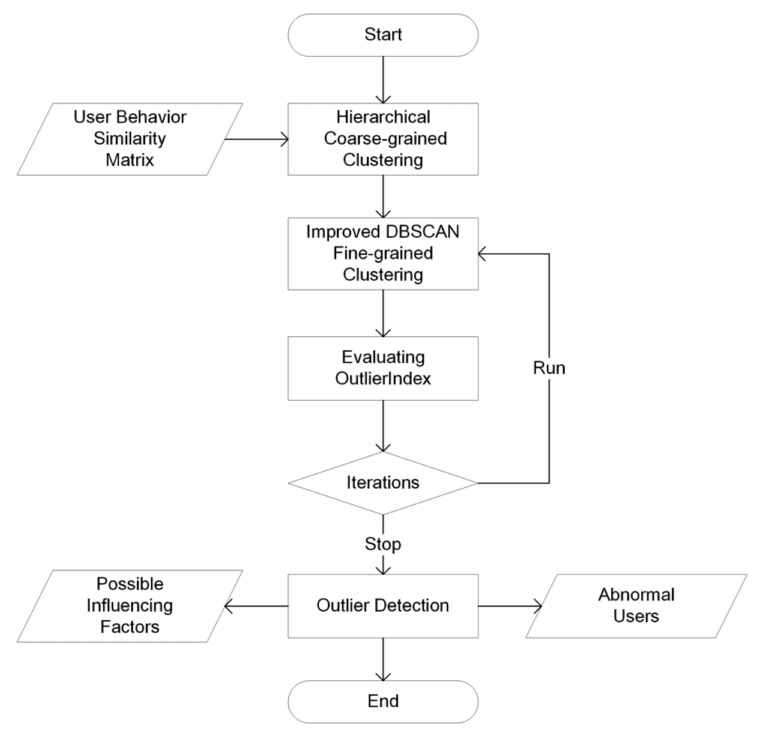
Figure 5. The algorithm flowchart of user behavior analysis in